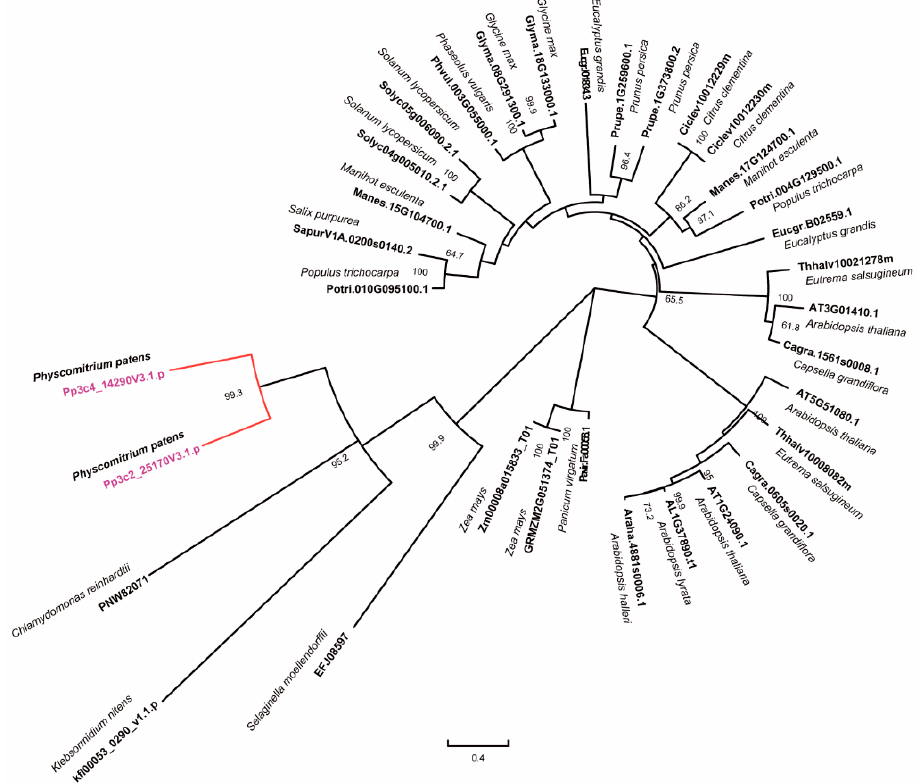
Figure 1. Phylogenetic analyses of RNase H1 in different species. The tree was constructed with MEGA-X using the maximum likelihood (ML) method with 1000 bootstrap replicates. The numbers above the branches represent the bootstrap support values (>50%) from 1000 replications.